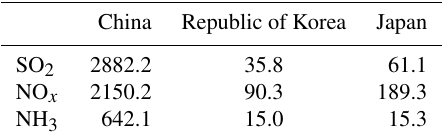
Table 1. The anthropogenic emission amounts used in this study. Units are Ggmonth − 1 for January 2015.